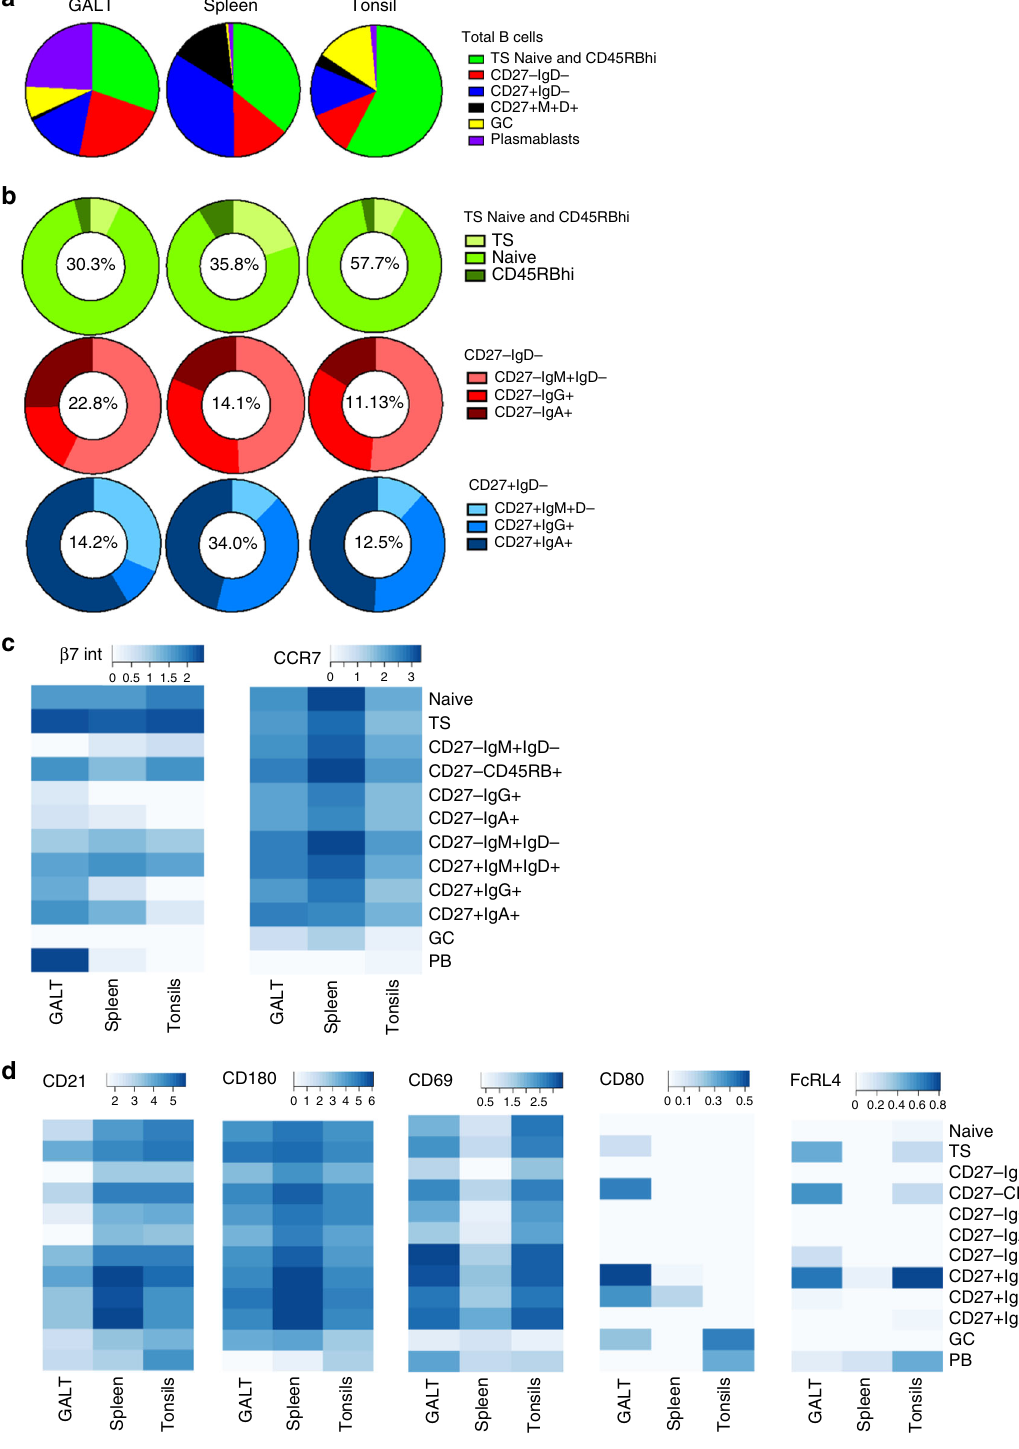
Fig. 3 Comparison of B cell subsets between tissues. Analysis of B cells in GALT ( n = 8); tonsil ( n = 5), spleen ( n = 6). a , b Pie charts illustrate that tissues contained different relative frequencies of B cell subsets. The numbers inside the donut charts are the percentages of total B cells in that tissue represented in the donut. c Heatmap of median expression of β 7 integrin and CCR7 in SPADE bubbles from each tissue indicating biases in migratory potential. d Heatmap of median expression of CD21, CD180, CD69, CD80 and FcRL4 showing that the same subset in different tissues can differ markedly in its surface antigen